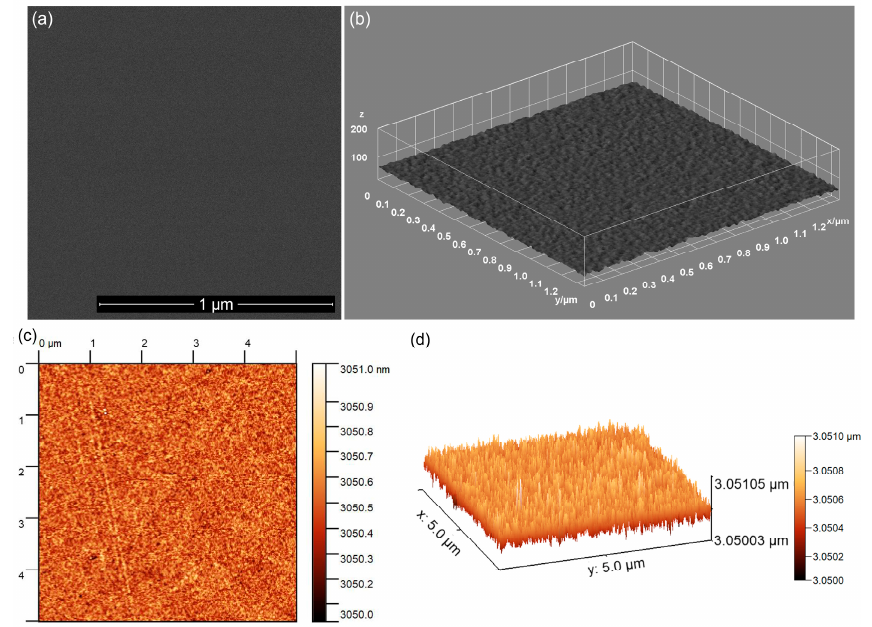
Figure 4. Two-dimensional (2D) ( a ) and 3D ( b ) SEM image of 10Ce-HAp coating and 2D atomic force microscopy (AFM) topography of 10Ce-HAp coating ( c ) and 3D representation of the surface topography of the 10Ce-HAp coating ( d ).